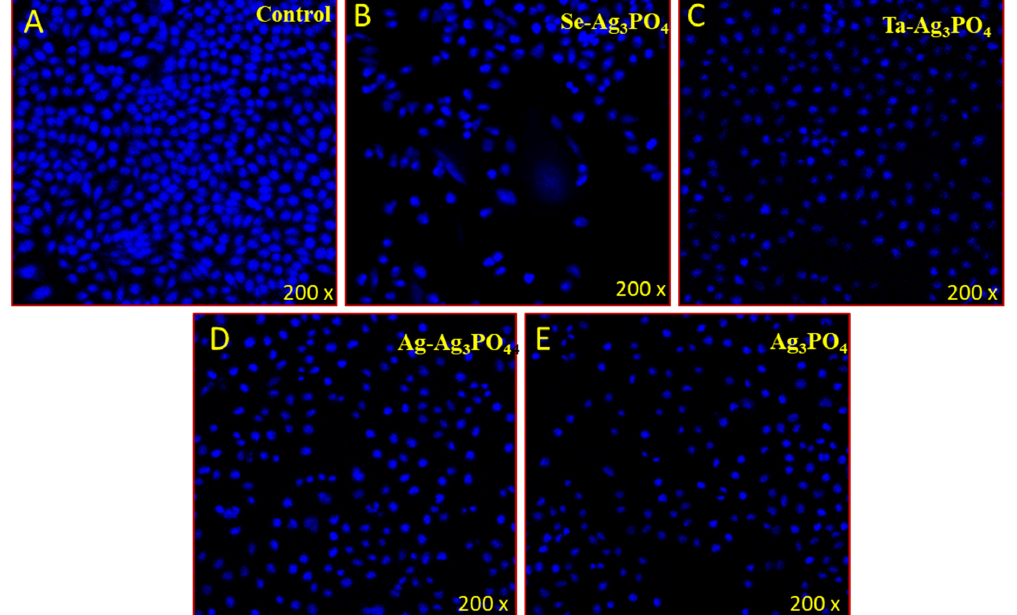
Figure 12. Cancer cell death due treatment of Ag 3 PO 4 , Se-Ag 3 PO 4 , Ag-Ag 3 PO 4 , and Ta-Ag 3 PO 4 . It shows the impact of the treatment of Ag 3 PO 4, Se-Ag 3 PO 4, Ag-Ag 3 PO 4 , and Ta-Ag 3 PO 4 on HCT-116 cells stained with DAPI post 48-h treatment. ( A ) is the control cell and ( B – E ) are Ag 3 PO 4 , Se-Ag 3 PO 4, Ag-Ag 3 PO 4, Ta-Ag 3 PO 4 , where a significant number of death cancer cells are observed upon (40 µg/mL) treatment.